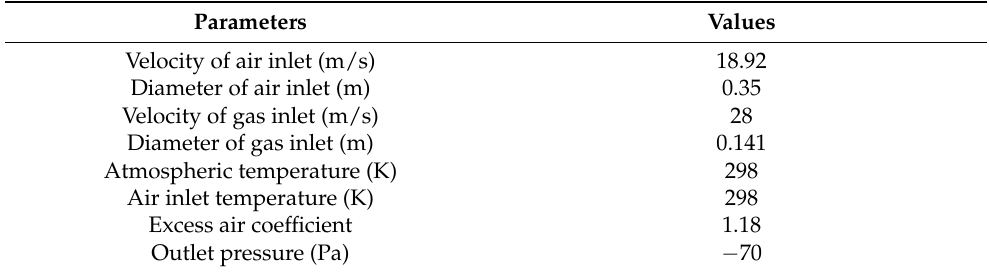
Table 2. Parameters for the experiments.